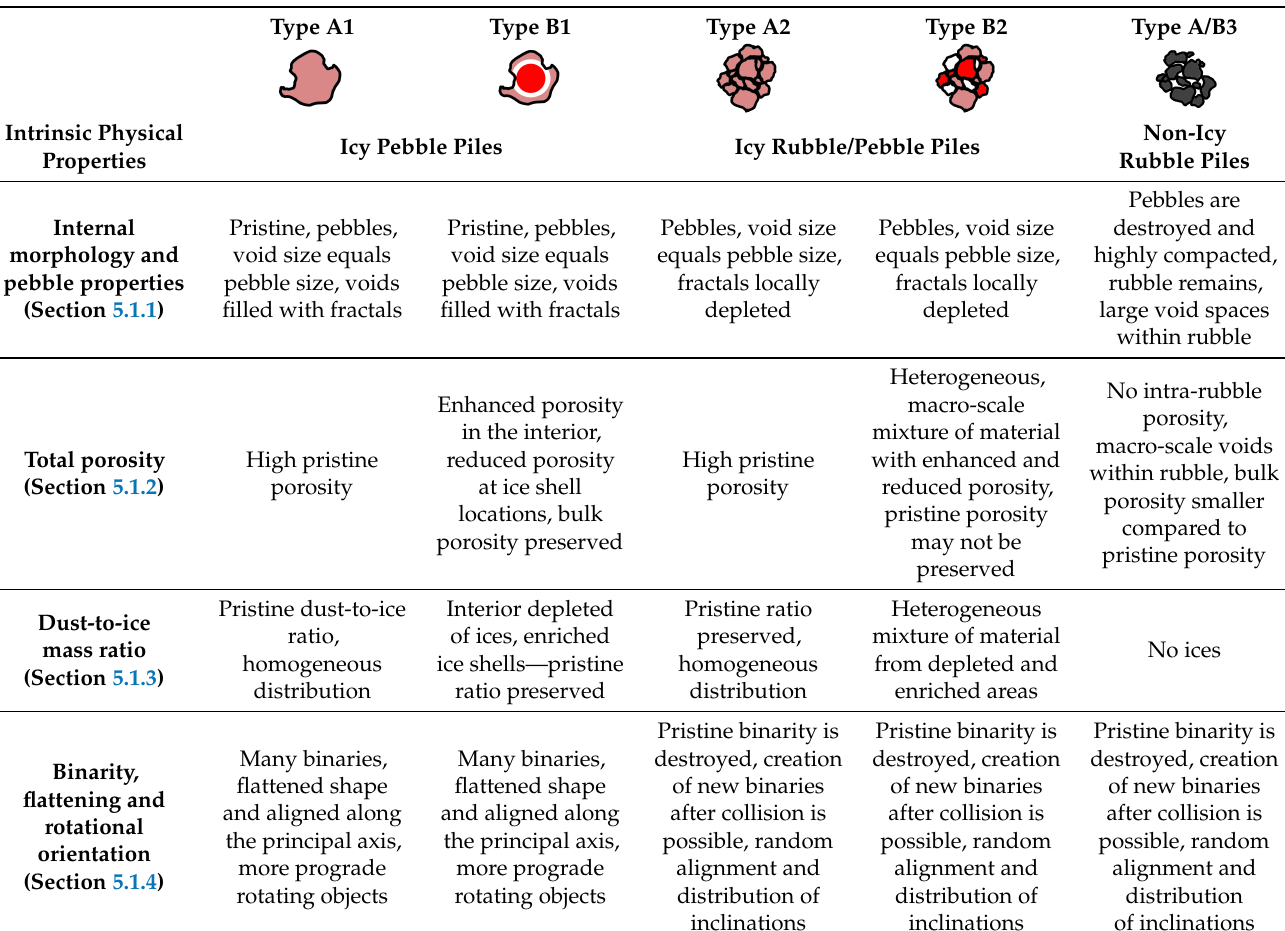
Table 1. Overview of the different proposed types of objects with their expected intrinsic physical properties as discussed in detail in the following